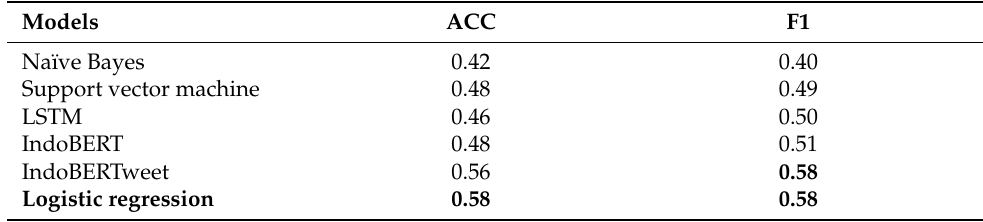
Table 2. Location prediction results using user tweets by majority